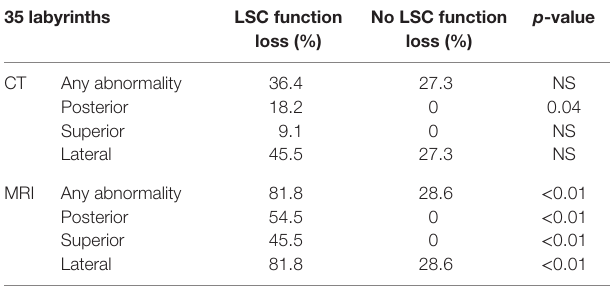
TaBle 1 | correlation between lateral semicircular canal function loss and imaging abnormalities on the right labyrinth.